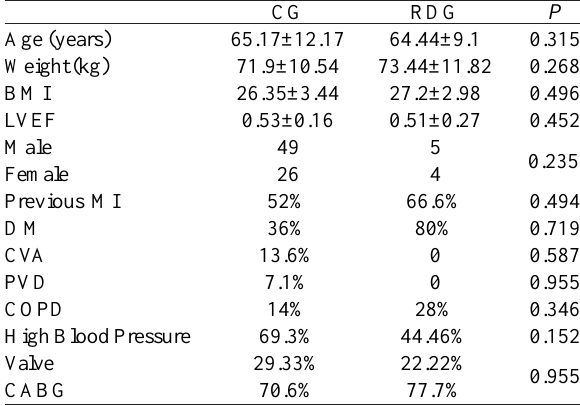
Table 1. Characteristics of the groups.